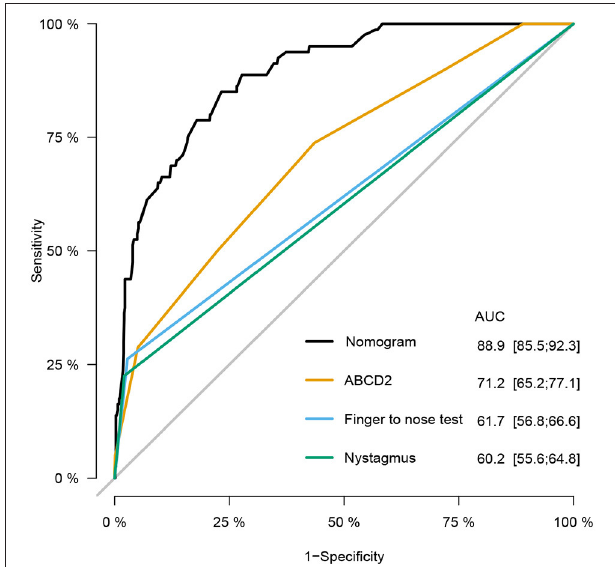
FIGURE 3 | Receiver operating characteristic (ROC) curves of the nomogram, age, blood pressure, clinical features, duration, and diabetes (ABCD2) score, finger to nose test, and nystagmus scheme for stroke prediction at emergency department (ED). Compared with the ABCD2 score, finger to nose test alone, and nystagmus scheme, the nomogram prediction model shows excellent diagnostic efficacy with especially high area under the ROC curve (AUC).